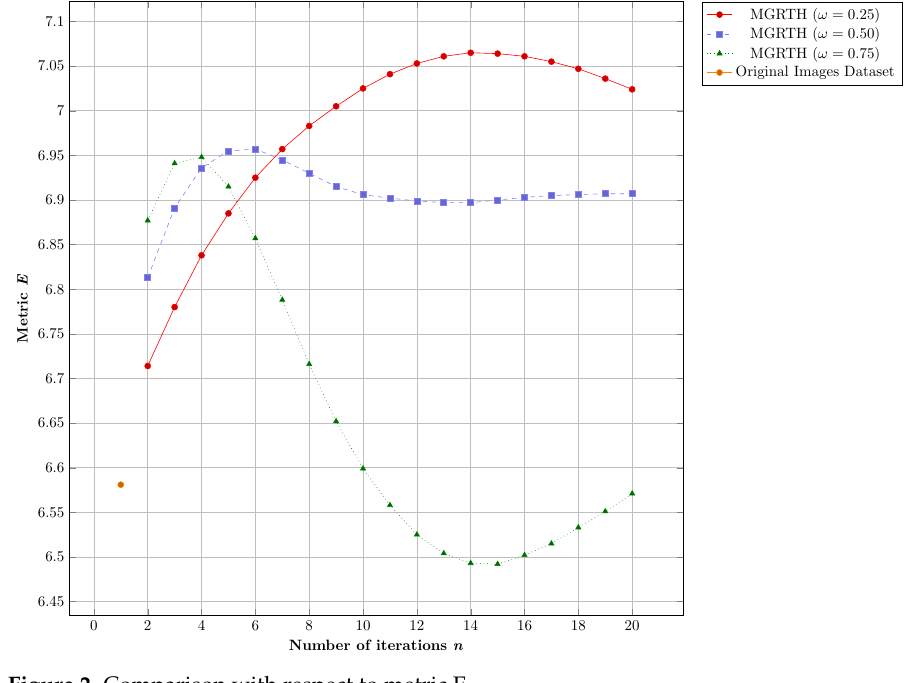
Figure 2. Comparison with respect to metric E.